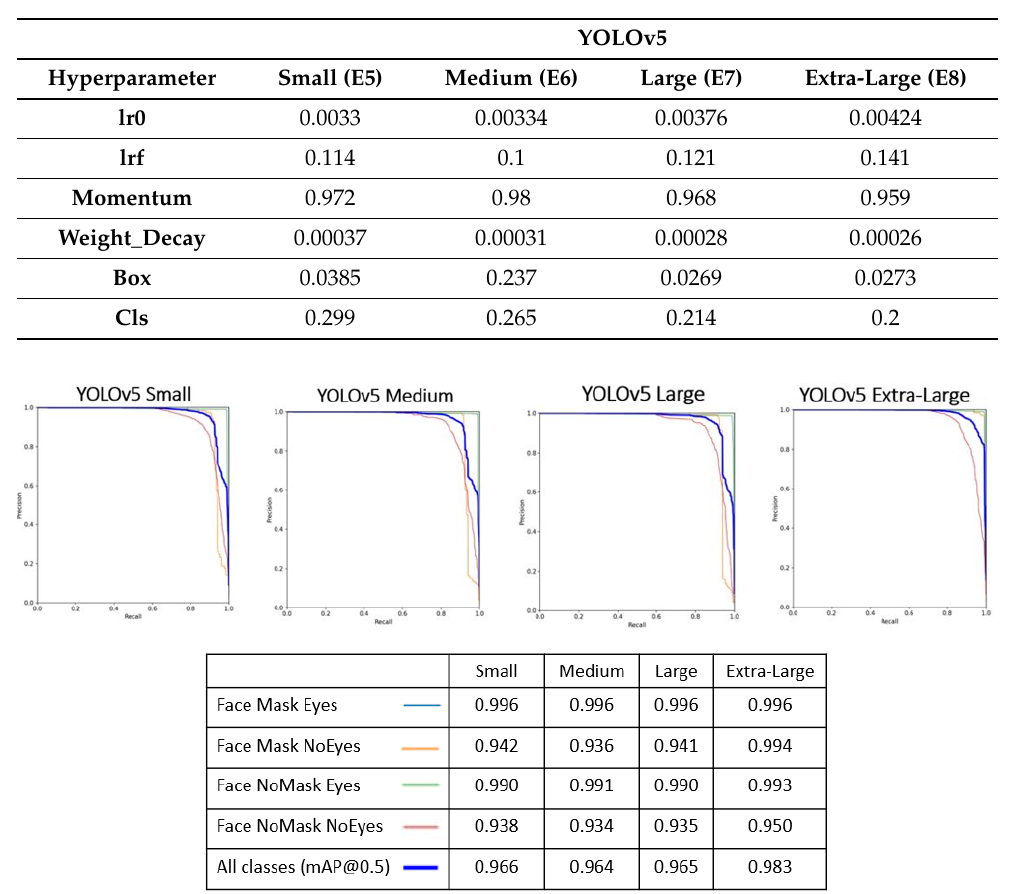
Table 12. Values assigned to main hyperparameters after performing Evolve technique of the YOLOv5 models, for the trials in Table 10.